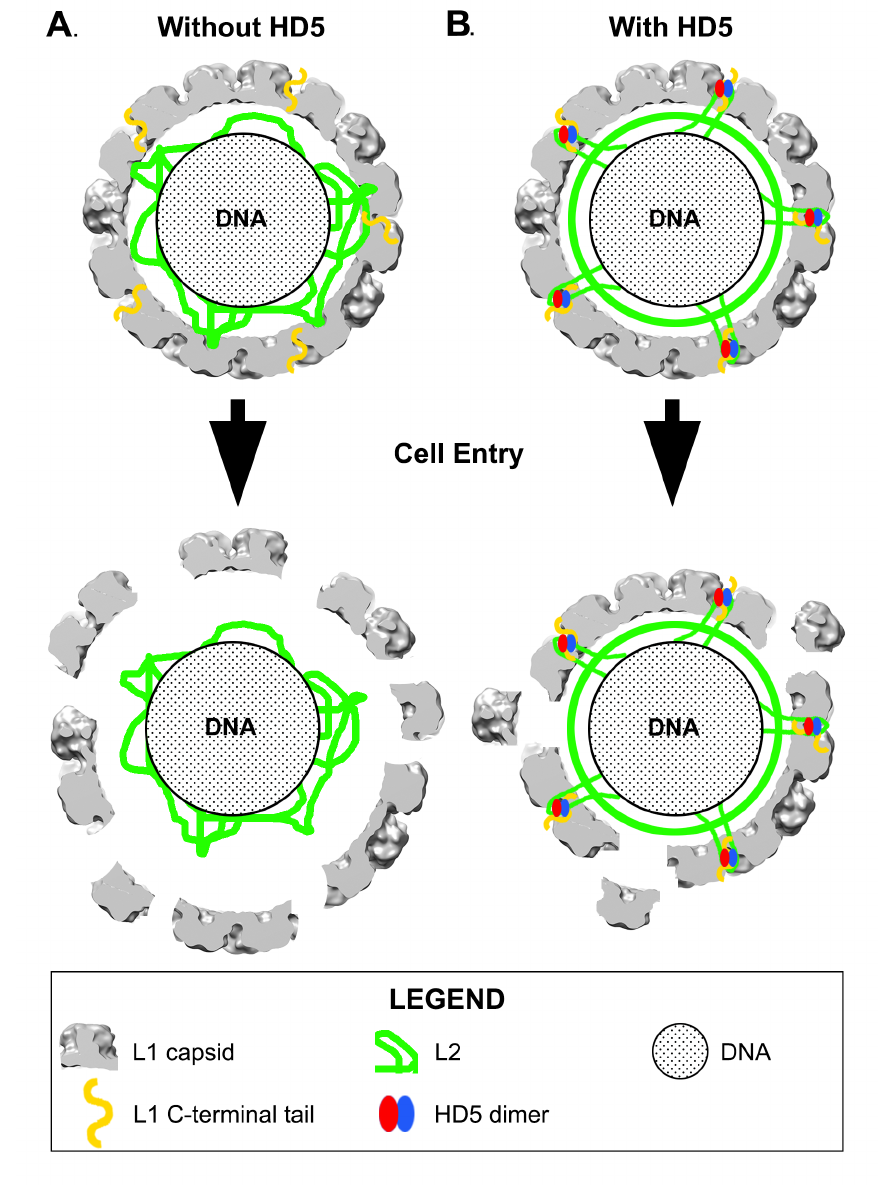
Figure 9. Diagram illustrating proposed effect of HD5 on HPV16 structure and cell entry. (A) In the absence of HD5, the ordered portion of the L1 capsid is represented by a central slab of the HPV16 cryo- EM density (gray), and some disordered L1 C-terminal tails (gold) are shown exposed on the exterior of the capsid. The disordered L2 protein (green) is represented as loosely associating with the L1 capsid and the encapsulated DNA genome (speckled region). After HPV16 enters the cell, the L1 protein dissociates from the L2/genome complex in the endosome. (B) In the presence of HD5, exposed L1 C-terminal tails are proposed to interact with HD5 dimers (red, blue) in depressions between L1 pentamers. In addition, negatively charged regions of L2 are proposed to be drawn through gaps in the L1 capsid and interact with HD5 dimers, effectively stabilizing the HPV16 capsid. After cell entry the virion is mostly held together by L1/L2/HD5